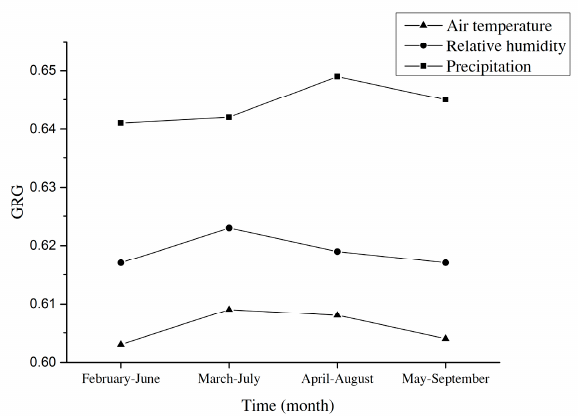
Figure 6. The GRGs of growing season EVI to air temperature, relative humidity and precipitation in